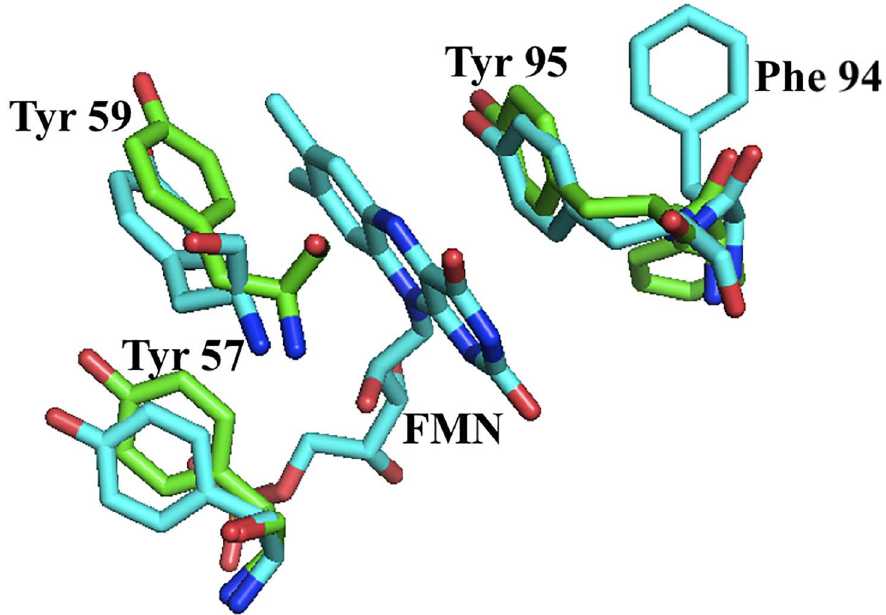
Fig 9. Stick representation of the aromatic/aromatic pairs established by the FMN sandwiching Y59 and Y95 residues with neighboring Y57 and F94,